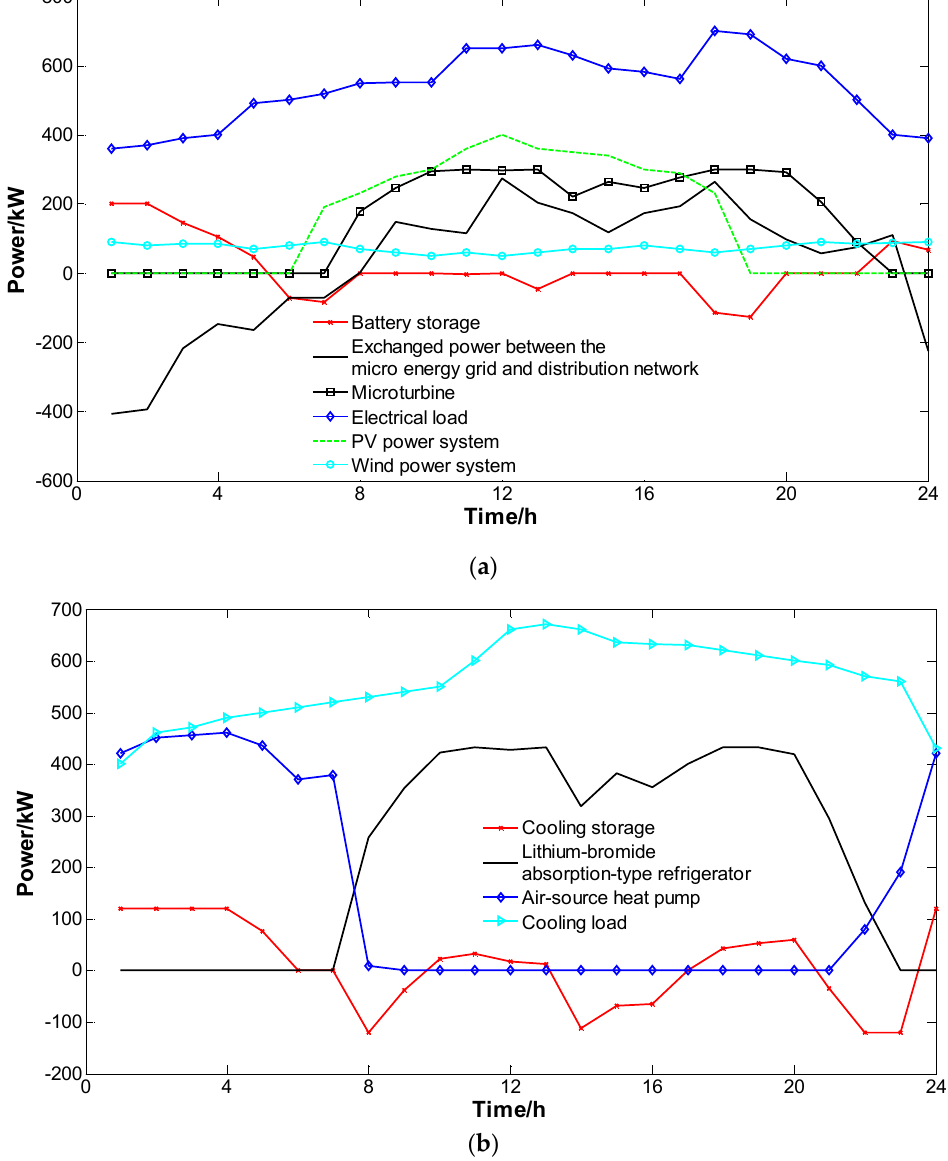
Figure 13. Electrical load ( a ) and cooling load ( b ) dispatching schemes of the micro energy grid for a typical day in the summer when the distribution network comprising the micro energy grid was in the optimal dispatching state.